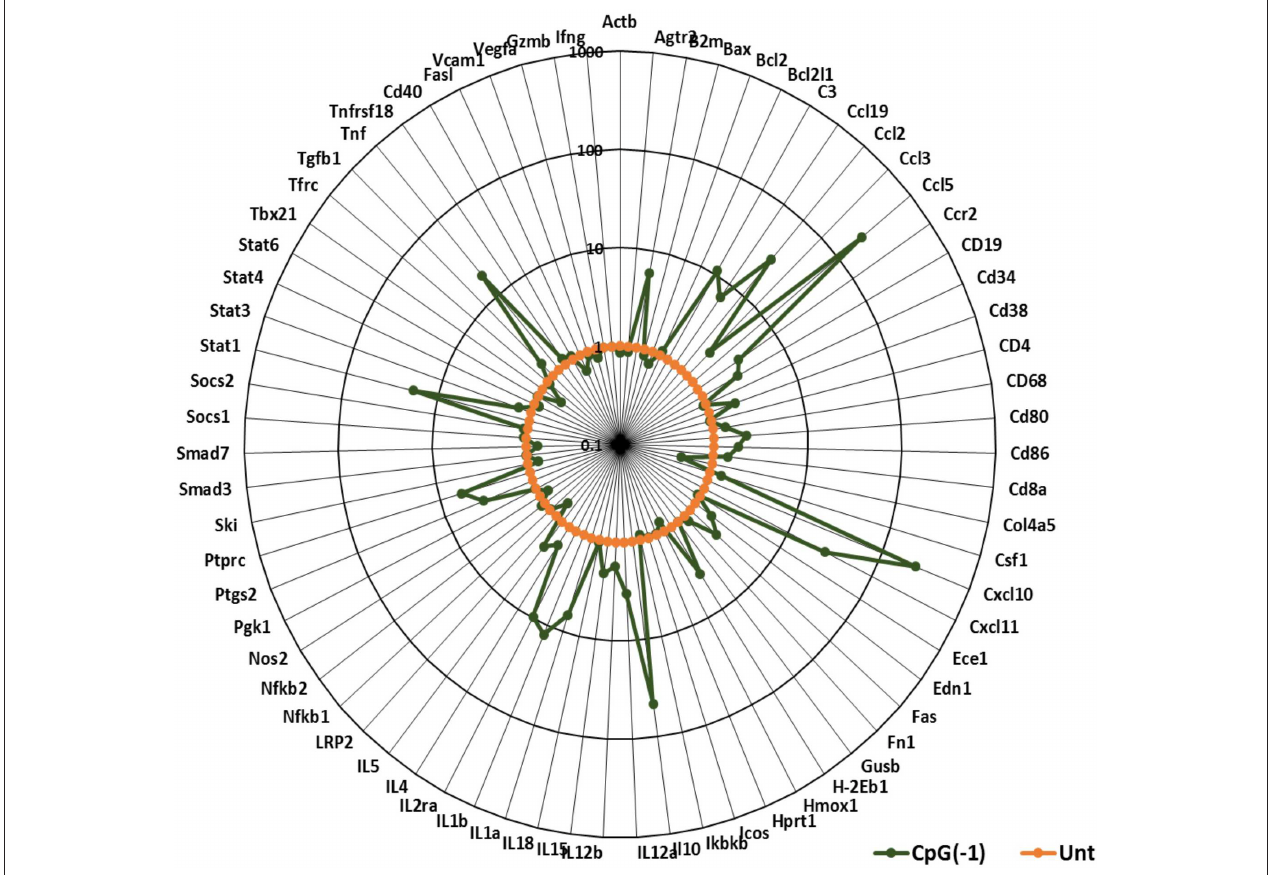
FIGURE 3 | CpG ODN treatment leads to pro-inflammatory and interferon gene signature in the CNS: B6-WT pups were injected with 50 µ g CpG ODN (10 µ L) intraperitoneally on P2. Untreated pups were used as controls. Brain samples were collected after perfusion 24h post-treatment. Gene expression profiles were generated using Taqman Low Density Arrays and expressed as fold increases over samples of untreated age-matched mice. The data represent 6 mice from three separate experiments. B2M, Beta-2-Microglobulin; C3, Complement C3; Edn1, Endothelin 1; Ptgs2, Prostaglandin-Endoperoxidase synthase 2; Ptprc, protein tyrosine phosphatase receptor type C; Tfrc, Transferrin